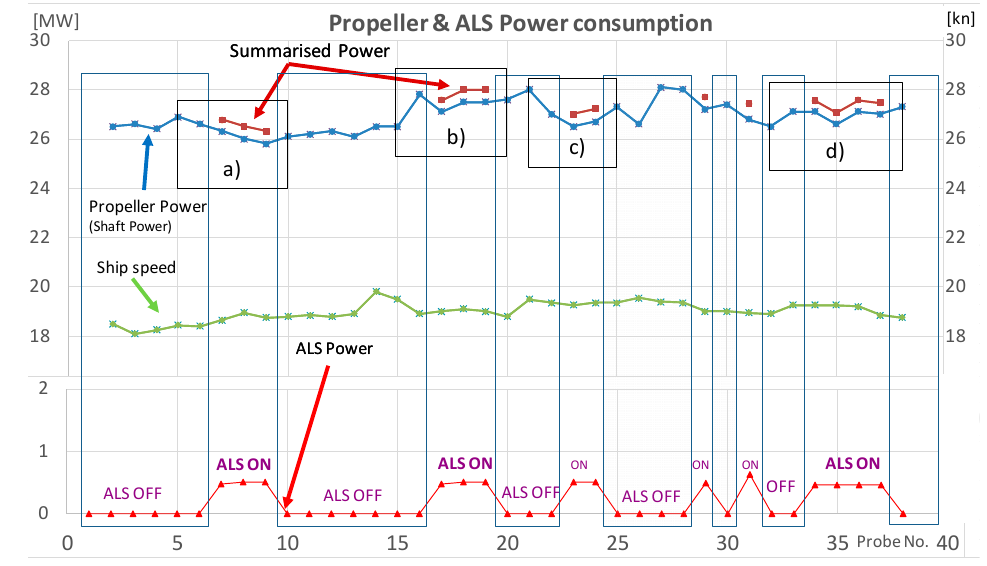
Figure 9. Air Lubrication Effect from Monitoring System on the large cruise liner. Table 2. Calculated parameters of propulsion system, based on the operating parameters recorded during passenger vessel sailing with ON and OFF